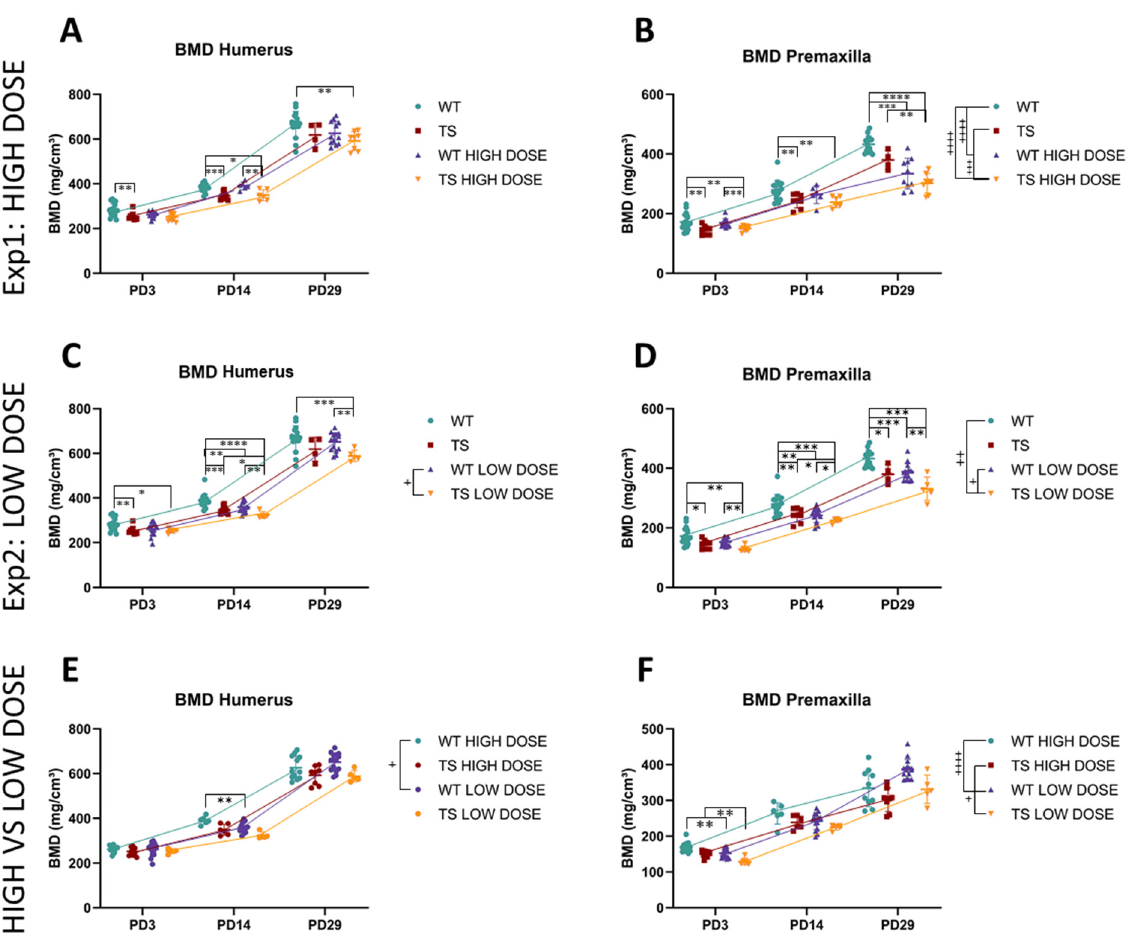
Figure 8. Postnatal bone mineral density of the humerus and premaxilla for wildtype and trisomic mice and the effects of high- and low-dose GTE-EGCG treatment across development. The in vivo µ CT scans of the humerus and premaxilla were used to determine the ( A , C ) BMD of the humerus and ( B , D ) BMD of the premaxilla at PD3, PD14, and PD29. ( E , F ) Comparison of the effects of the high-dose and the low-dose treatment. Data are presented as the mean +/-standard deviation. ( + ) p < 0.05; ( ++ ) p < 0.01; ( +++ ) p < 0.001; ( ++++ ) p < 0.0001; mixed-effects analysis across timepoints; (*) p < 0.05; (**) p < 0.01; (***) p < 0.001; (****) p < 0.0001; pairwise tests by timepoint. Sample size: Experimental setting 1: (PD3) WT = 18 (19 BMD premaxilla), TS = 9 (8 BMD premaxilla), WT treated = 12 (13 BMD premaxilla), TS treated = 9; (PD14) WT = 18, TS = 8, WT treated = 6, TS treated = 6; (PD29) WT = 15 (14 BMD premaxilla), TS = 4, WT treated = 12 (10 BMD premaxilla), TS treated = 8. Experi ‐ mental setting 2: (PD3) WT = 18 (19 BMD premaxilla), TS = 9 (8 BMD premaxilla), WT treated = 15 (14 BMD premaxilla), TS treated = 5 (6 BMD premaxilla); (PD14) WT = 19 (18 BMD premaxilla), TS = 8, WT treated = 15, TS treated = 5 (6 BMD premaxilla); (PD29) WT = 15 (14 BMD premaxilla), TS = 4, WT treated = 15, TS treated = 5. The mice analyzed may differ across stages but represent overall ontogenetic trajectories.